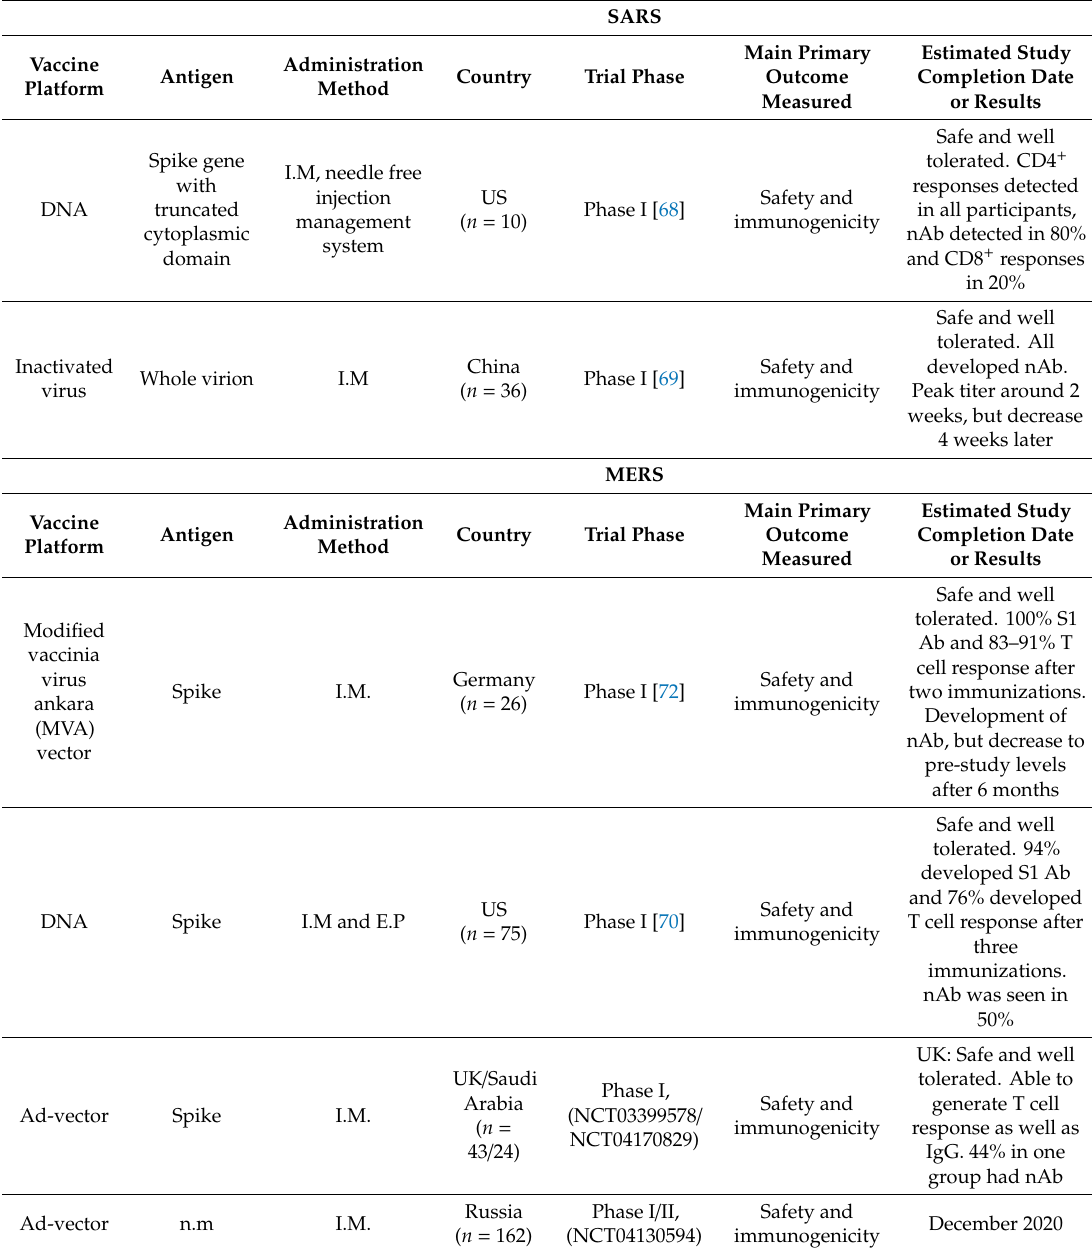
Table 1. Di ff erent vaccine platforms and their respective trials for severe acute respiratory syndrome (SARS) and Middle East respiratory syndrome (MERS)